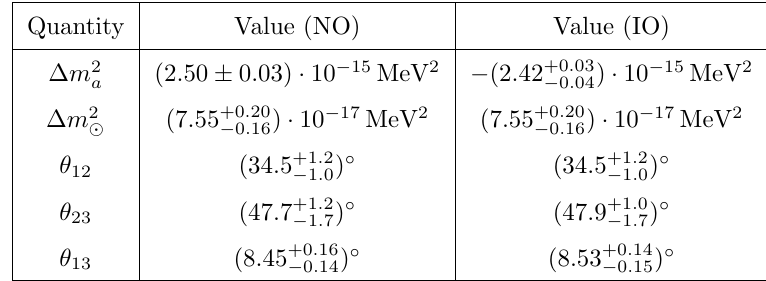
Table 2 . Neutrino mass di(cid:11)erences and mixing angles in the vacuum used throughout the paper for normal mass ordering (NO) and inverted ordering (IO) [30]. We denote (cid:1) m 2 . (cid:1) m 2 = m 2 (cid:0) m 2 (cid:12) 2 1 the layer radii and densities are collected in table 1. Depending on the azimuthal angle (cid:18) , neutrinos can traverse 1,3,5,7 or 9 Earth layers. Other numerical inputs used throughout the paper are collected in table